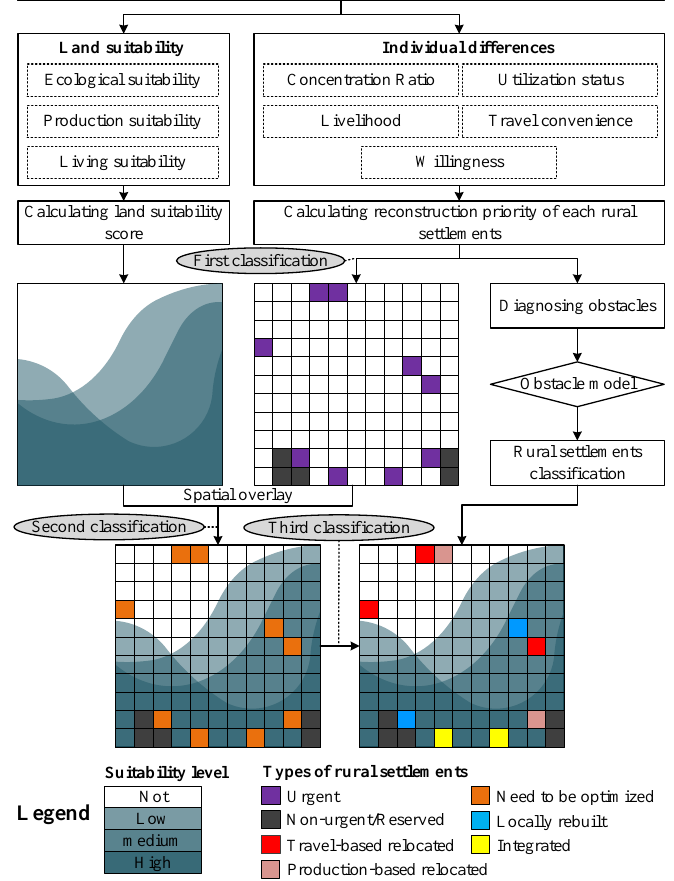
Figure 2. Framework of rural settlement reconstruction.